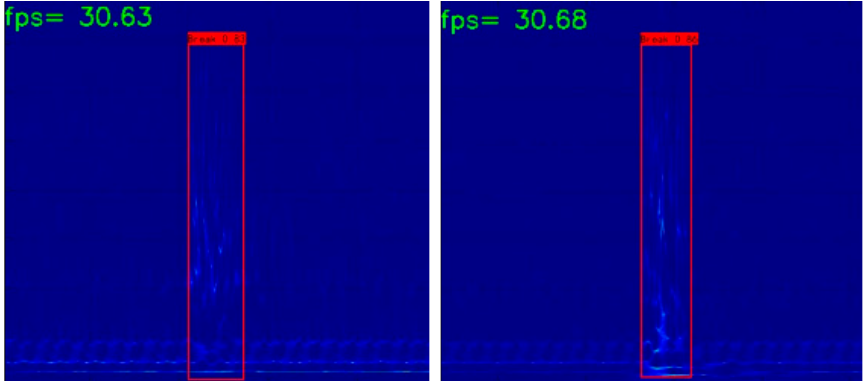
Figure 11. Examples of wire break detection results based on well-tuned YOLOXs.